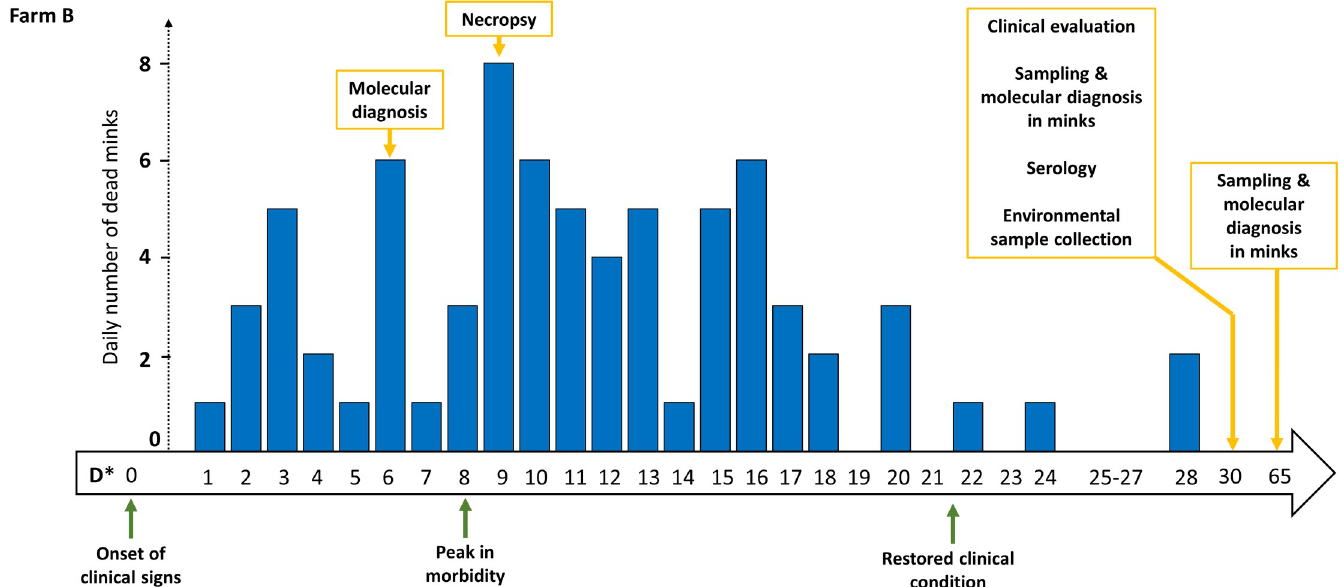
Fig 5. Timeline of the events observed in farm B. Yellow arrows indicate sampling procedures; green arrows refer to the clinical observations, with the peak being associated with the highest approx. percentage of animals exhibiting signs at the specific time-point. The bar chart depicts the number of dead minks recorded at each time-point (day; D �